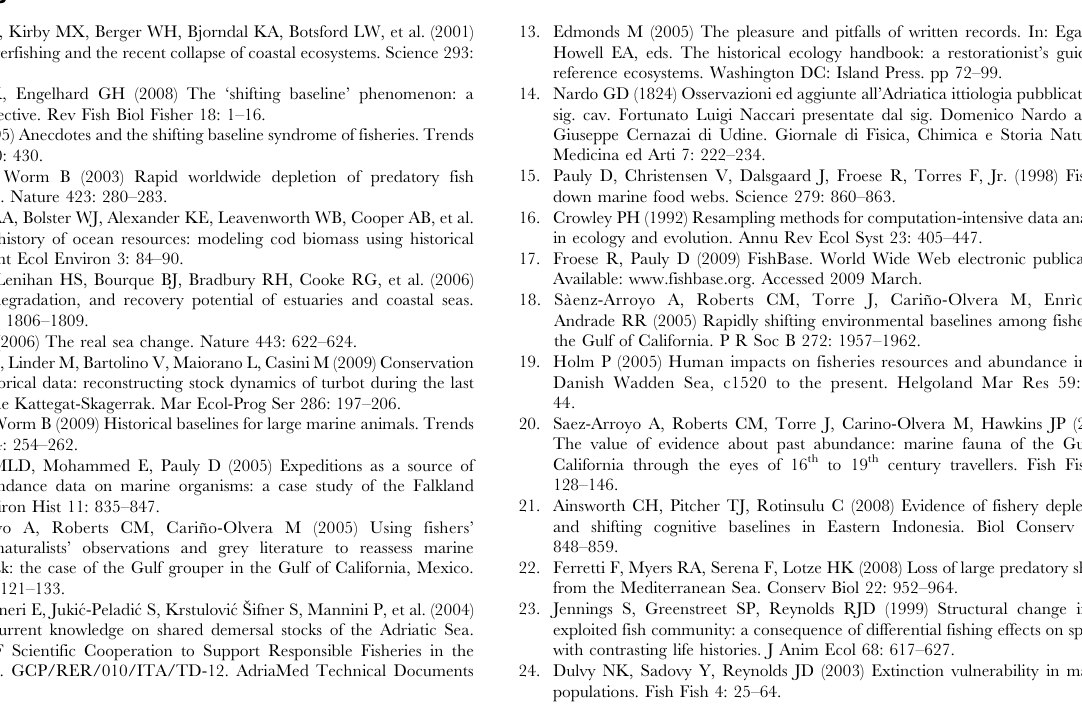
Table S5 Class weights, computed using the intercalibration, and their association with classes of perceived abundance. (DOC) Table S6 List of species described in naturalists’ documents and the species’ ecological characteristics according to Fishbase. (DOC) Table S7 Categories of taxon -specific properties based on information from Fishbase. (DOC) Table S8 Results of the analysis of trends for fish community structure indicators (N = 255 species; years 1800–1950), where significant ( a = 0.1) slopes are shown in bold. (DOC) Table S9 Results of the analysis of trends for fish community structure indicators (N = 87 species/groups of species; years =1800–2000), where significant ( a = 0.1) slopes are shown in bold.